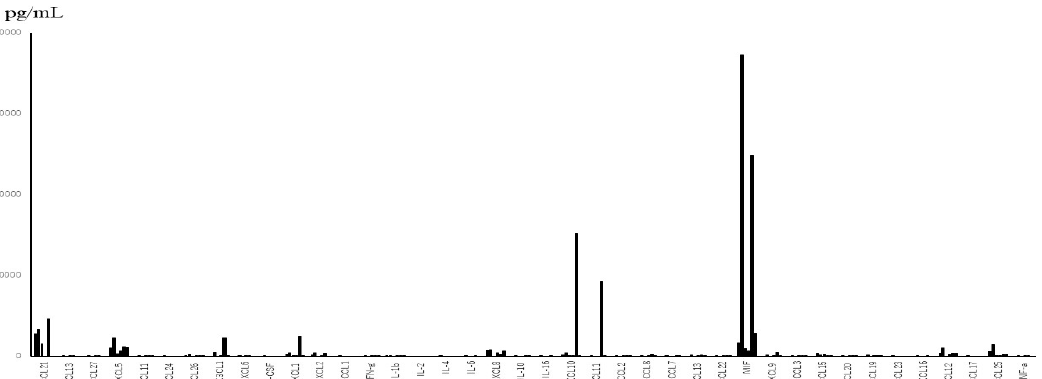
Figure 1. Levels of 48 chemokines and interleukins in the tracheal aspirate fluid (TAF) obtained from 6 patients with severe disease during the acute phase. The main detectable cytokines in TAF were chemokines rather than inflammatory cytokines (interleukins).